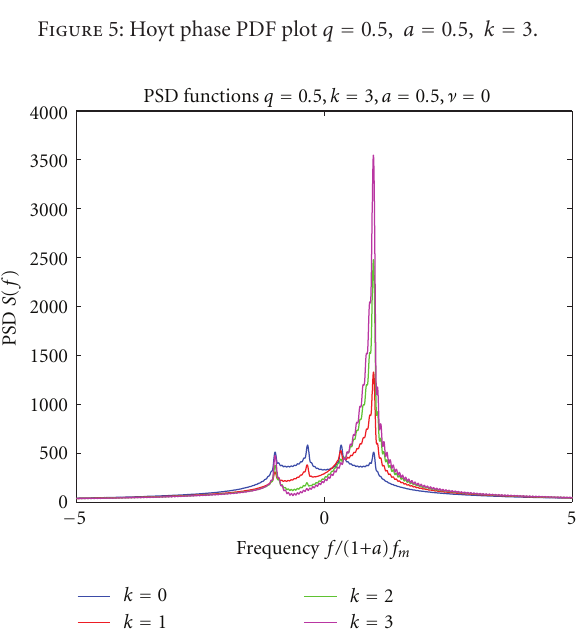
Figure 3: Output of the hoyt simulator.